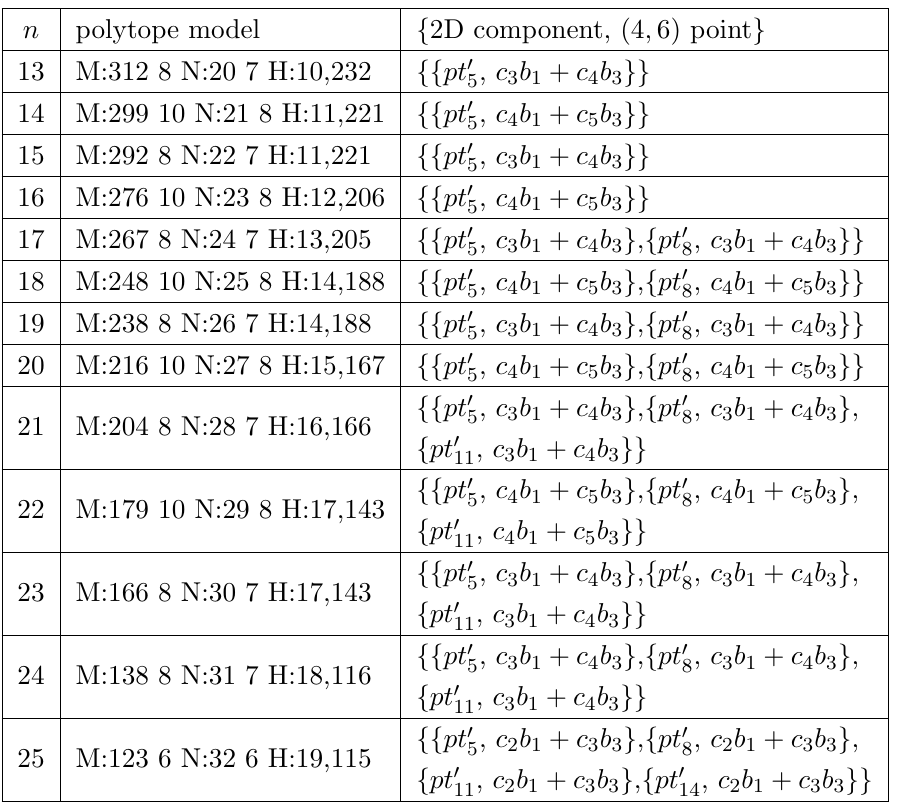
Table 20. Polytope tunings of M:348 5 N:12 5 H:5,251 (generic model over F 3 ): so ( n )-tunings